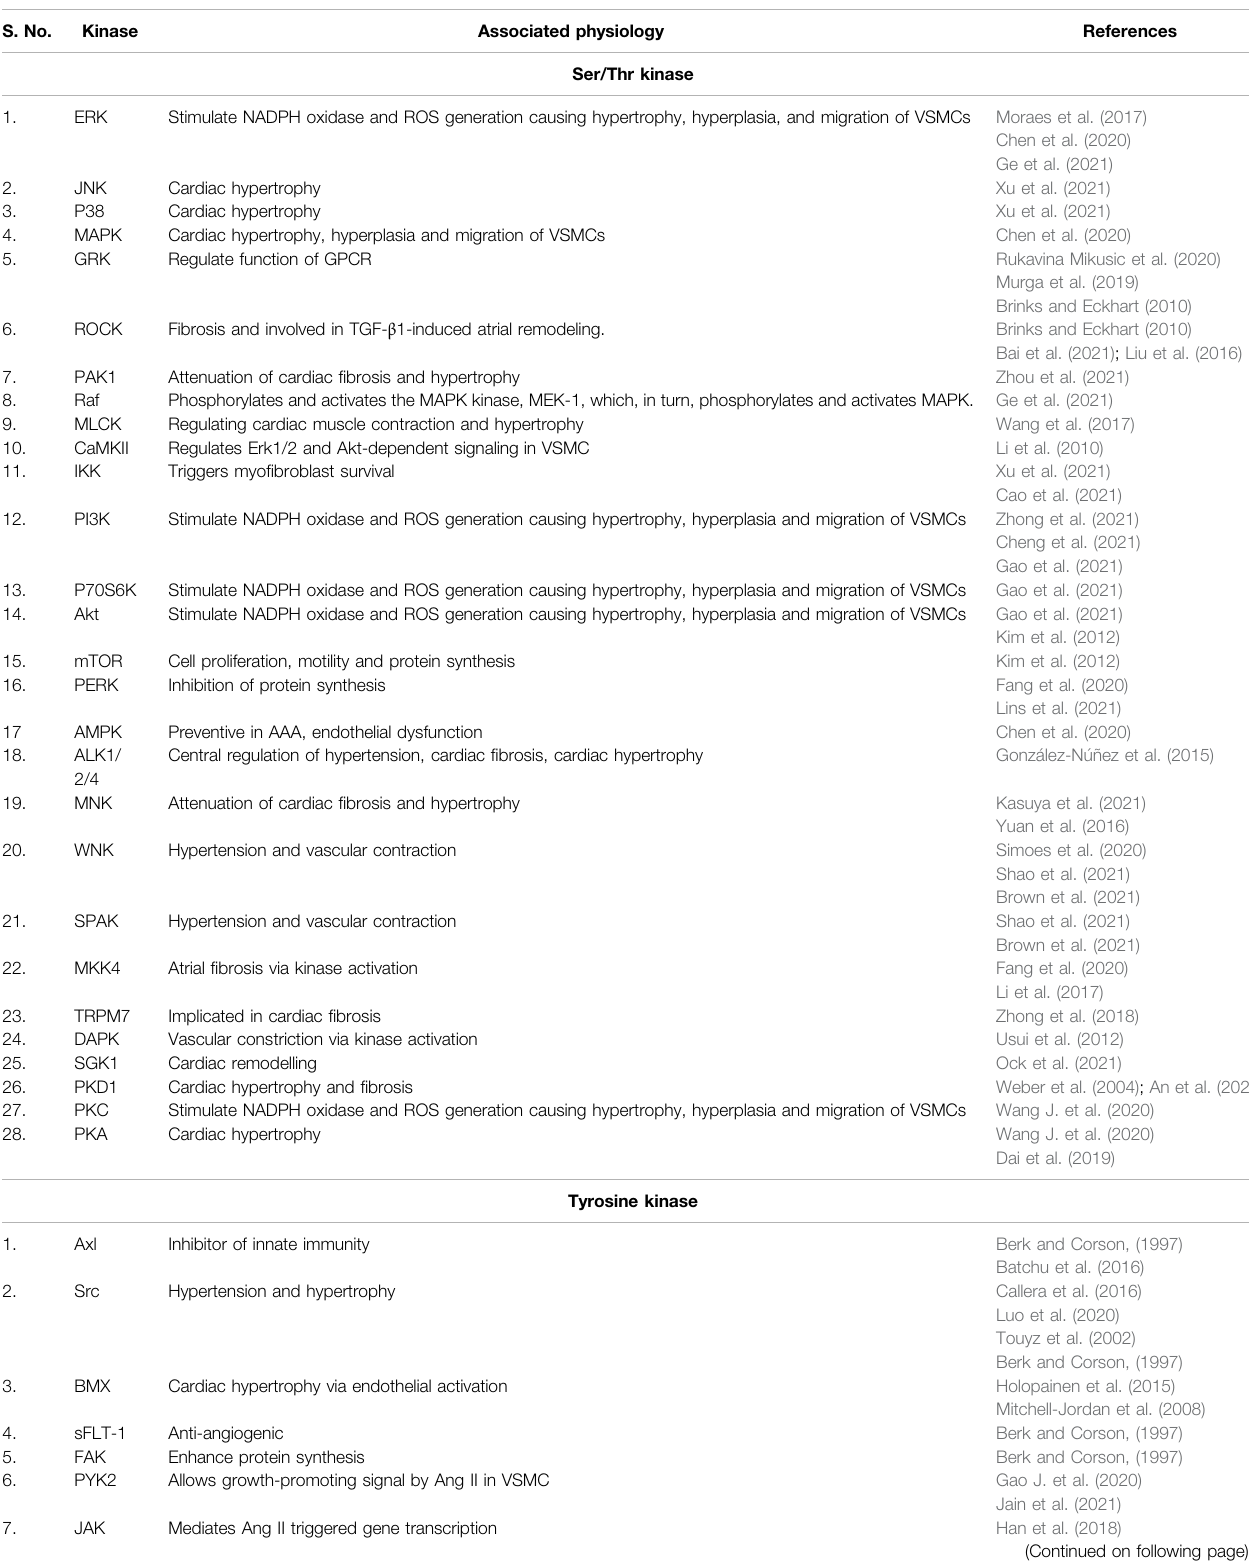
TABLE 2 | Identi fi ed protein kinases in ANG II signaling in cardiovascular